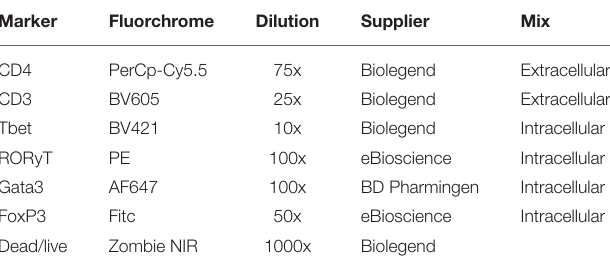
TABLE 1 | Antibody mix for staining of splenic cells. Marker